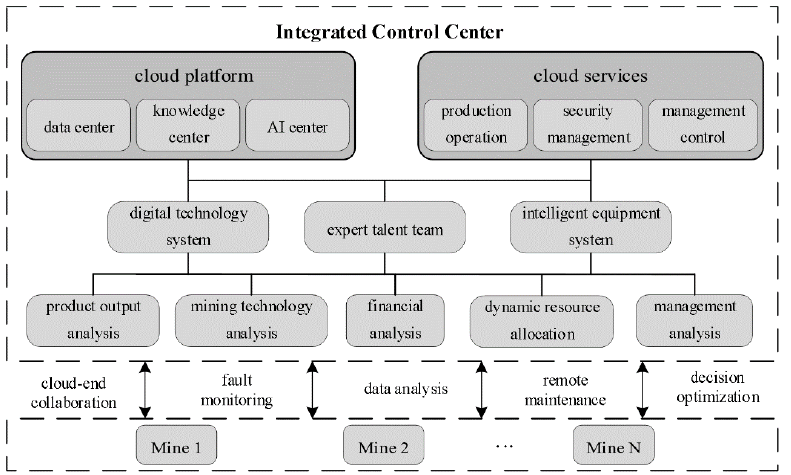
Figure 4. The structure of enterprise centralized management and control scenarios.